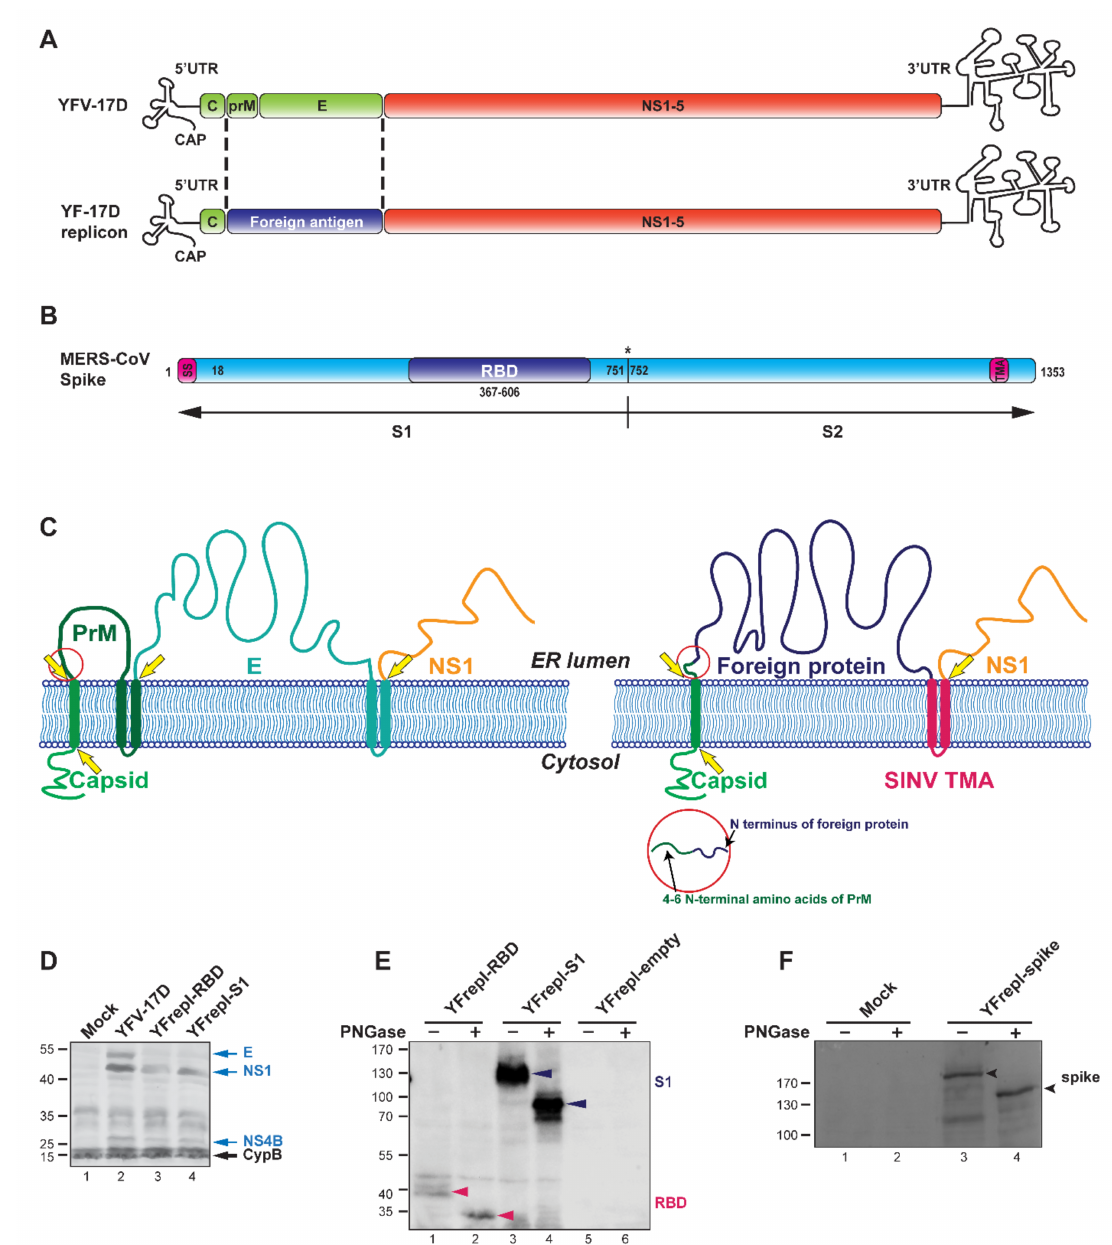
Figure 1. Design and characterization of YF-replicons expressing the RBD or S1 domain of the MERS-CoV S protein. ( A ) Schematic representation of the YFV genome and that of a YF replicon, in which the sequences encoding the glycoproteins prM and E are replaced by a sequence encoding a foreign protein. ( B ) Schematic representation of the MERS-CoV spike protein and its subdomains; SS—signal sequence; TMA—transmembrane anchor. Cleavage site between S1 and S2 is illustrated with an asterisk. ( C ) Cartoon showing the membrane topology of the YFV (left panel) and YF replicon (right panel) polyprotein. The yellow arrows indicate cleavage sites in the viral/replicon polyprotein. The bars that traverse the membrane represent the transmembrane anchors (TMA) of the N-terminally located protein. The red circle highlights the prM amino acid sequence retained at the site of the luminal cleavage that releases the N-terminus of the foreign insert. ( D ) Western blot analysis confirming the expression and processing of YF-replicon polyproteins, as compared to YFV-17D, using a polyclonal serum against YFV. Arrows on the right indicate the viral proteins (blue) and the intracellular chaperon cyclophilin B (CypB), which was used as a loading control (black). ( E , F ) Western blot analysis of the expression and glycosylation status of the RBD (red arrow)/S1 (black arrow) domains ( E ) or the full-length S protein ( F , black arrow), expressed from YF replicons as indicated. Treatment with PNGase revealed the expected glycosylated nature of each of these